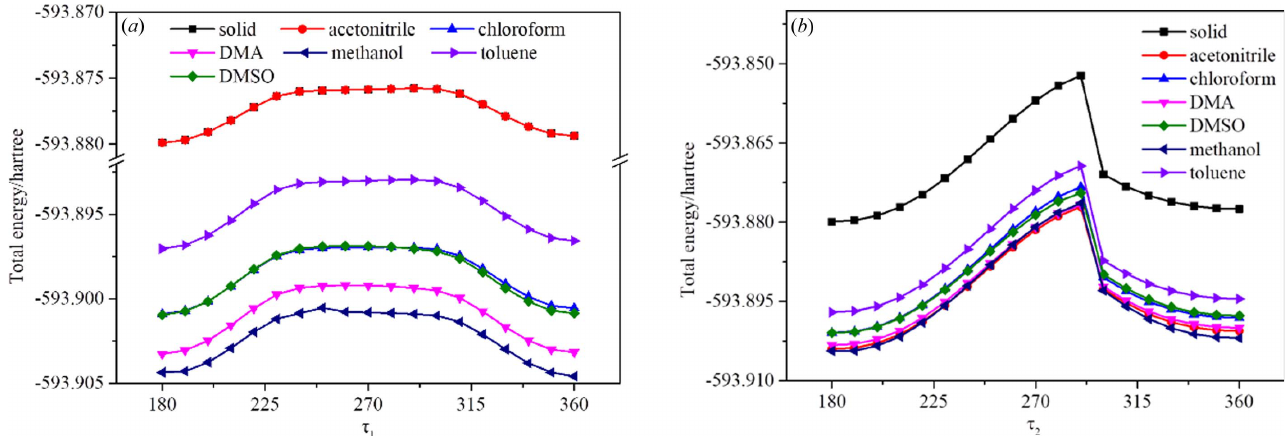
Figure 10 ( a ) Potential energy surface of PHEN (cid:7) 1 in solid and different solvents, ( b ) potential energy surface of PHEN (cid:7) 2 in solid and different